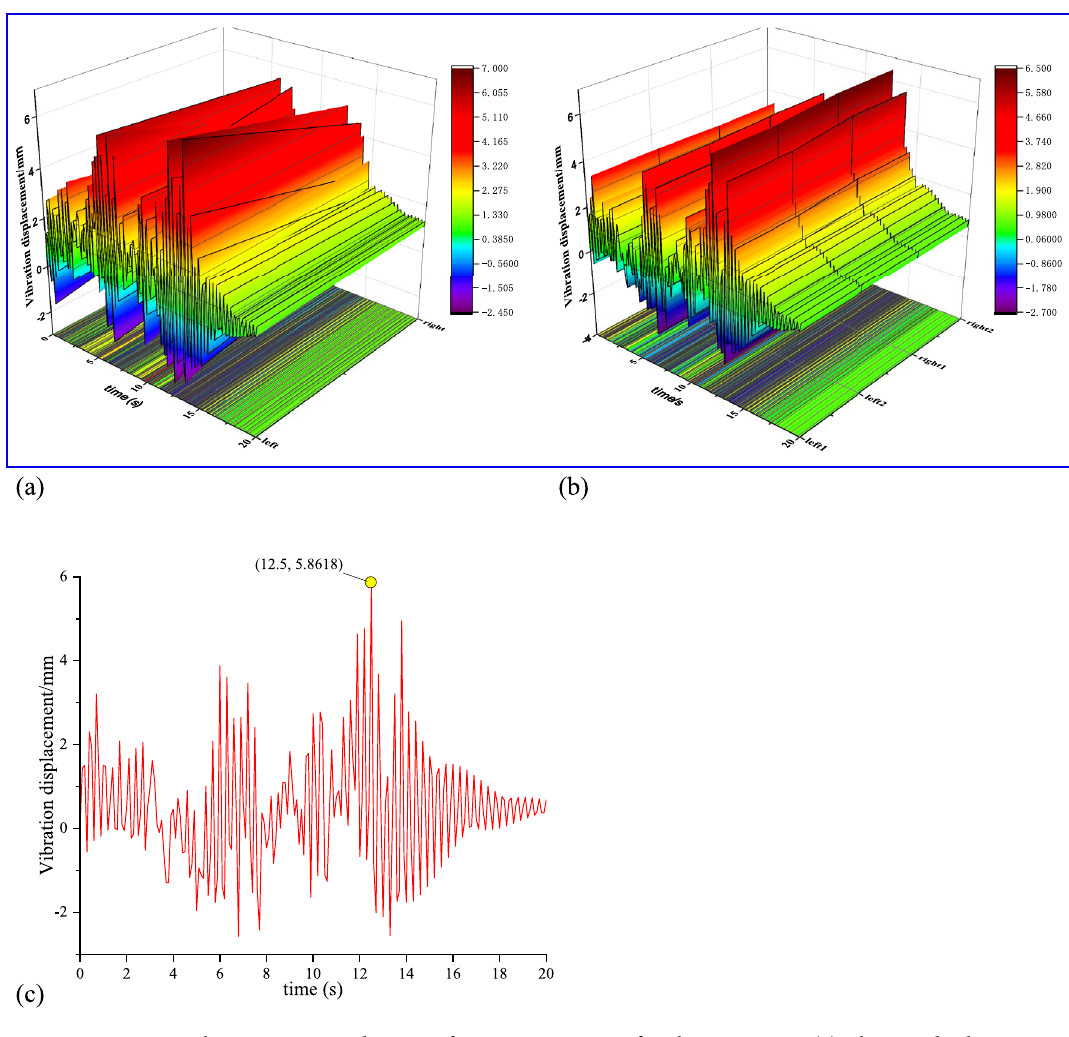
Figure 10. Vibration response diagram of main components of anchoring system: ( a ) vibration displacement diagram of top anchor and anchor cable beam; ( b ) vibration displacement diagram of front and rear support column beam; ( c ) vibration displacement diagram of support